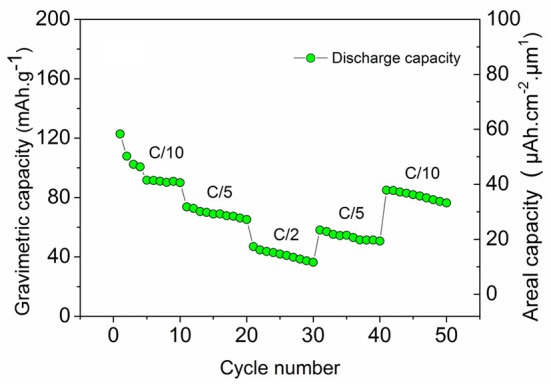
Discharge capacity of the microbattery TiO2 nts/Polymer/LNMO(100EP) at multi-C rates.